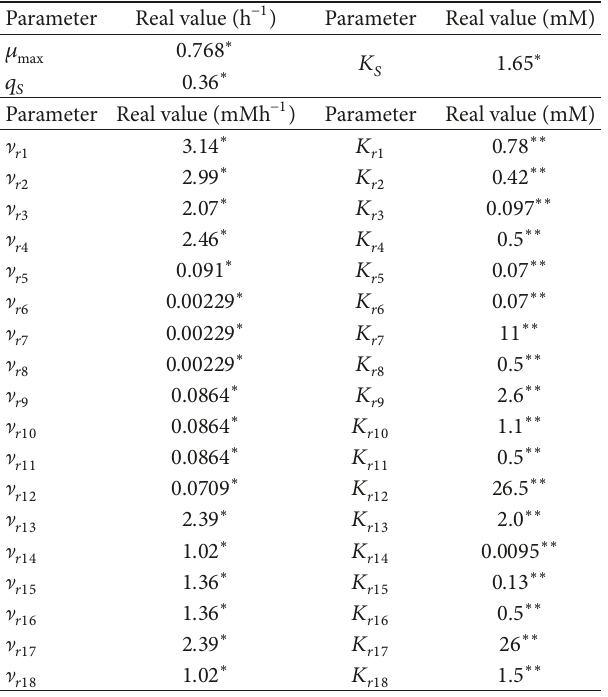
Table 1: Parameter values used to simulate the metabolic network.